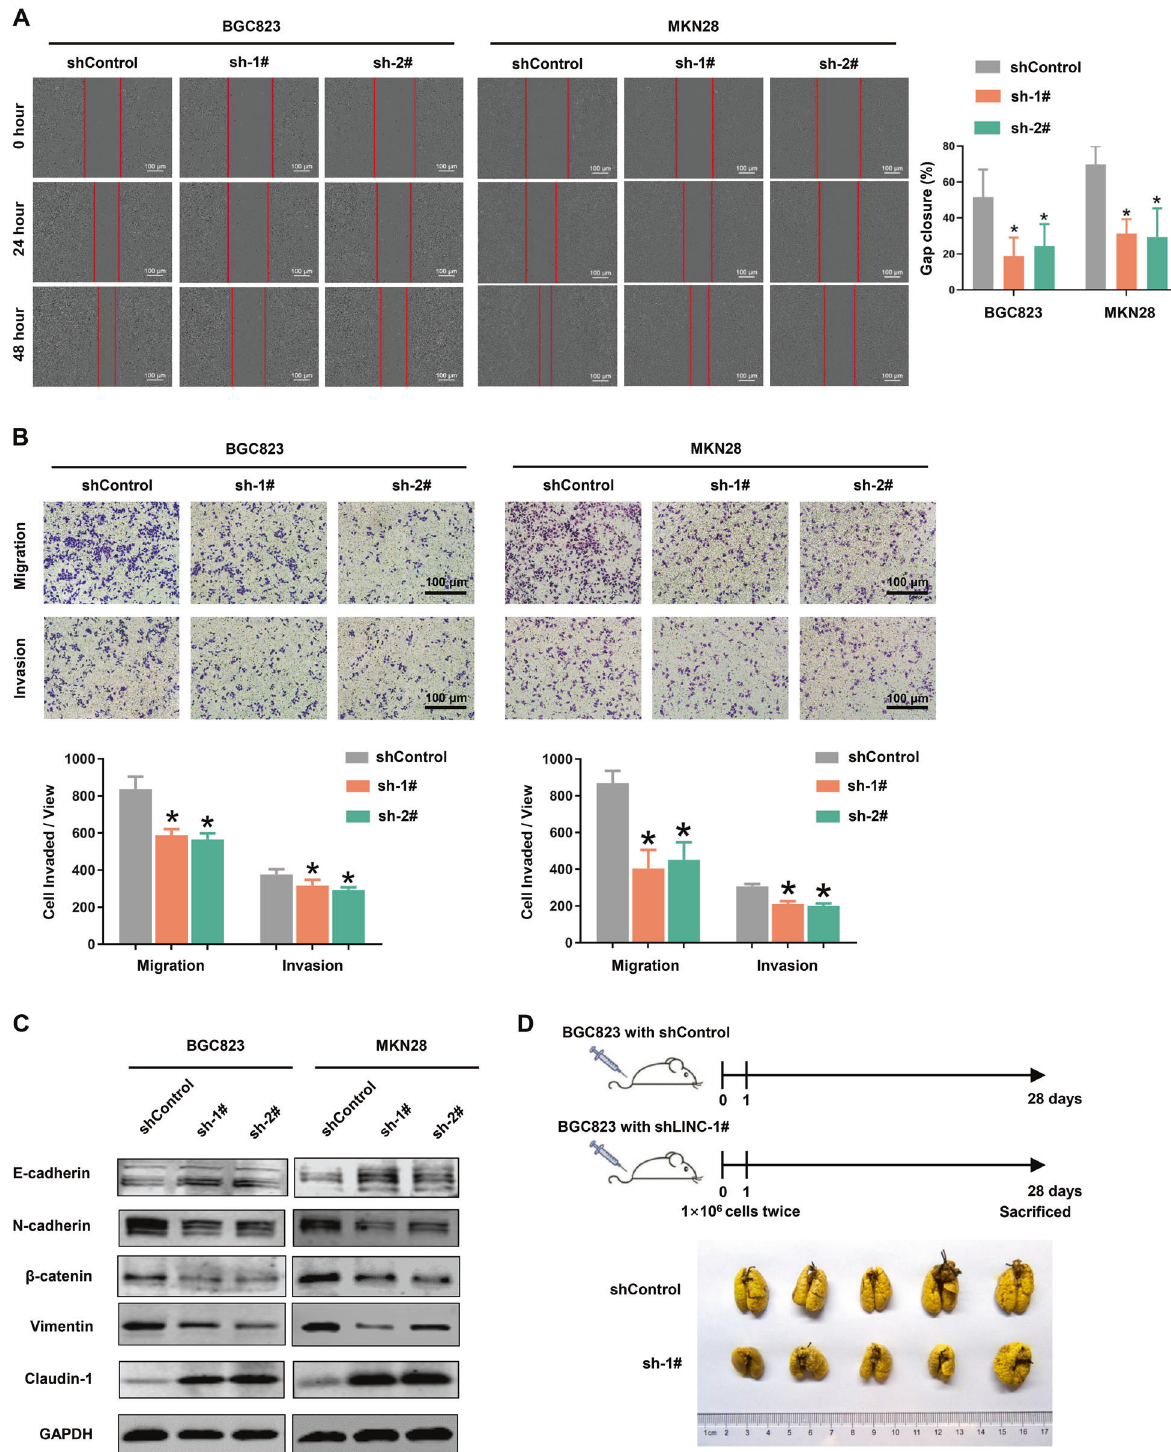
Fig. 4 Knockdown of LINC00205 attenuated GC cell migration and invasion both in vitro and in vivo. A Wound-healing assay was used to determine the mobility of GC cells. B GC cells were further assayed for their invasive capability with or without Matrigel on transwell chambers. n = 6 independent experiments, * P < 0.05 vs shControl. Scale bar, 100 μ m. C Western blot analysis of EMT-related proteins E- Cadherin, N-Cadherin, β -catenin, Vimentin, and Claudin-1. D The effects of LINC00205 on metastatic colonization through blood circulation. Knockdown of LINC00205 attenuated BGC823 cells ’ colonization to the lungs.